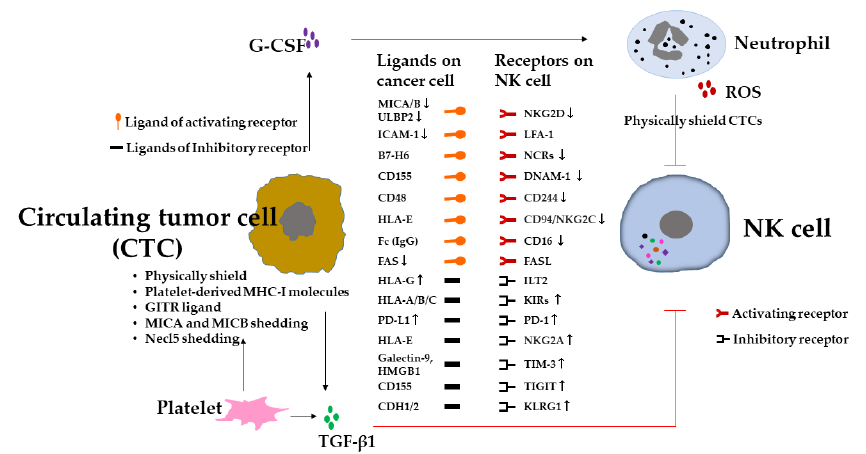
Figure 2. Circulating tumor cells (CTCs) evade surveilling NK cells during metastasis. For success- fully metastasis, tumor cells have to evade from NK-cell-mediated immunosurveillance. Tumor cells have several strategies involving tumor cell intrinsic features and tumor-driven extrinsic microenviro- ment factors to subvert their recognition and elimination by NK cells. Intrinsic features endow tumor cells with distinct metastatic potential owing to epigenetic and genetic alterations that include the downregulation of NK cell activating receptor ligands and/or the upregulation of NK cell inhibitory receptor ligands. In contrast, the tumor-cell-driven extrinsic microenvironment suppresses NK cell immunosurveillance through modulation of activating receptors and/or inhibitory receptors on NK cells. Platelets and neutrophils may favor the escape of CTCs from NK cell immunosurveillance, thereby supporting CTCs to establish metastasis. (Arrows indicate the change in expression levels of surface